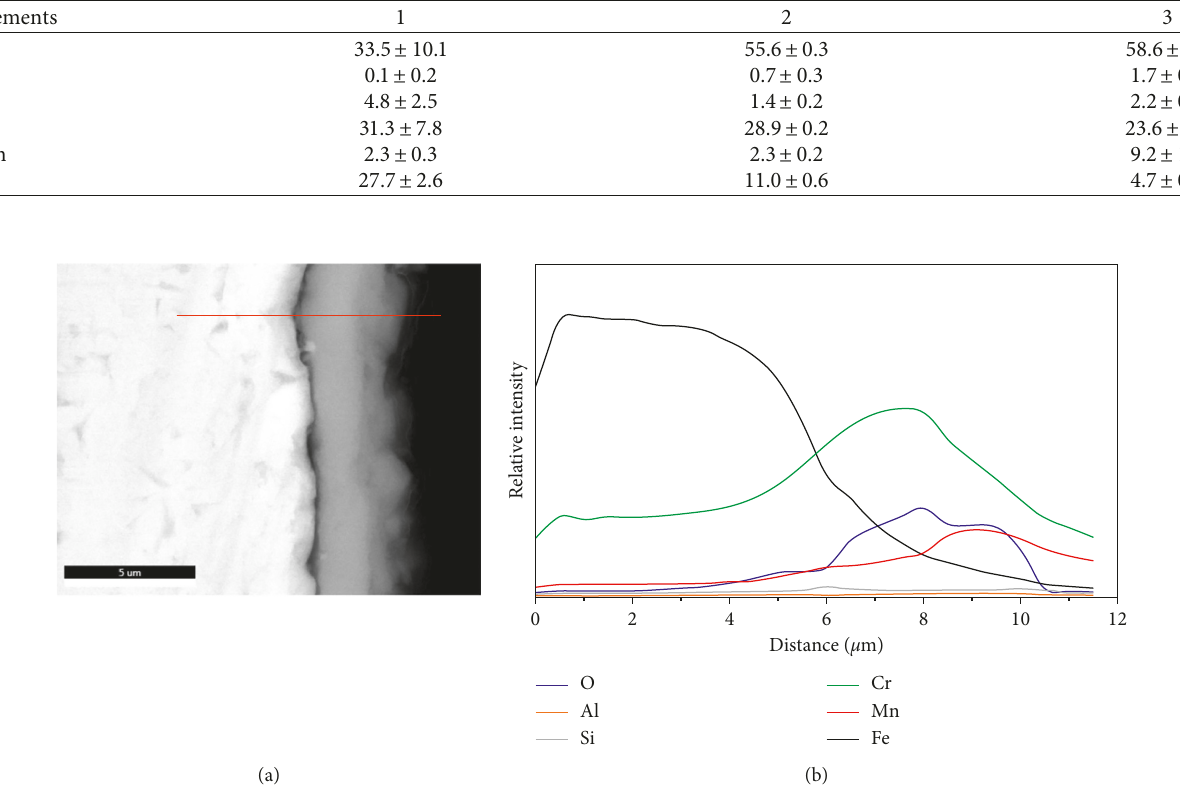
Figure 20: Line scan analysis of the cross section of the B-127 (YSZ)